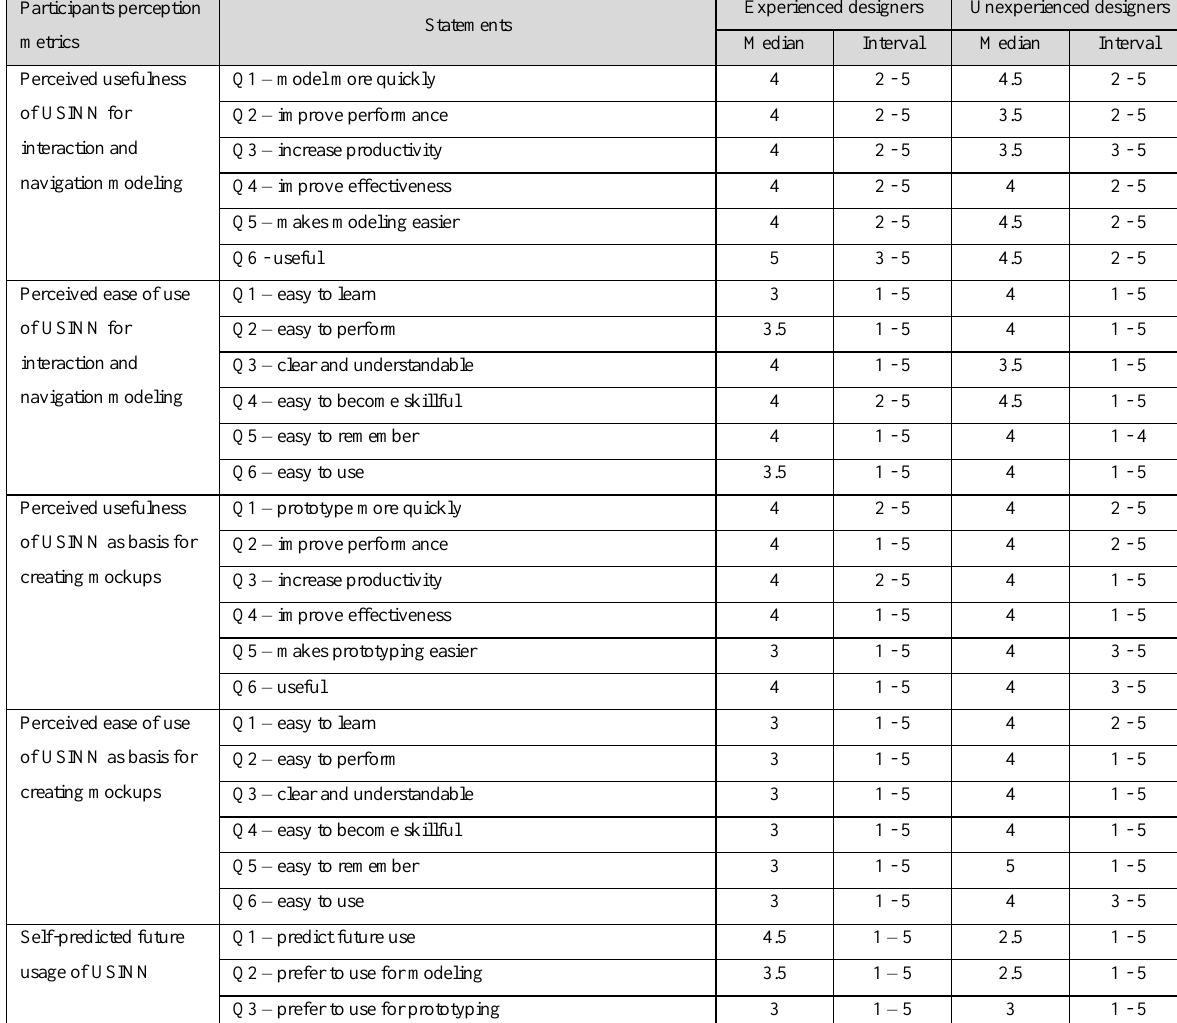
TABLE IX. M EDIAN VALUES OF THE PARTICIPANTS PERCEPTION METRICS (O RDINAL SCALE : 5 STRONGLY AGREE TO THE POSITIVE STATEMENT – 1 STRONGLY AGREE TO THE NEGATIVE STATEMENT